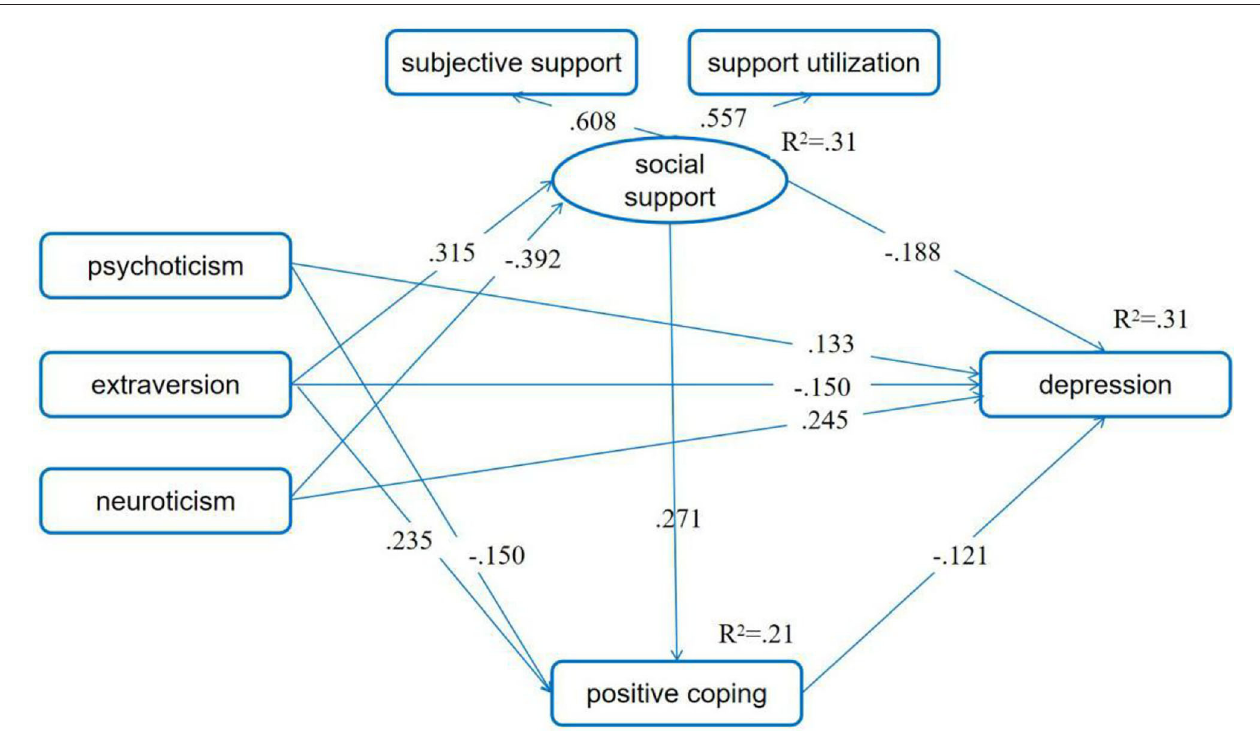
FIGURE 1 | Positive coping and social support as chain mediators between personality and depressive symptoms. Standardized path coefficients are presented in the model ( p s < 0.05). The first pregnancy or not, having adverse pregnancy experience or not, being pregnant as planned or not, and number of weeks of pregnancy were set as control